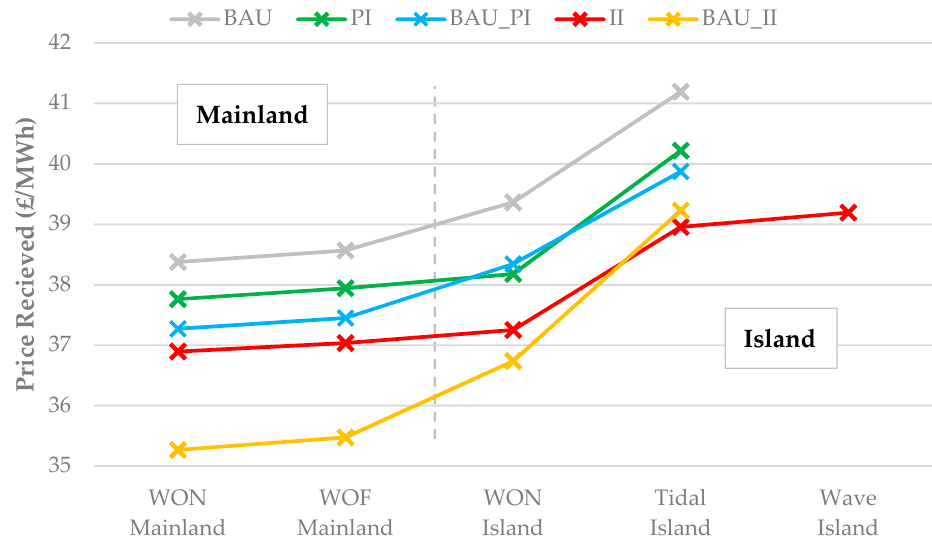
Figure 10. Average price received by generator by island and mainland locations. Island wind can receive a higher price due lower correlation in supply, but this is reduced with increased capacity (PI & II). Marine energy can consistently receiver a higher price due to the difference in resource.